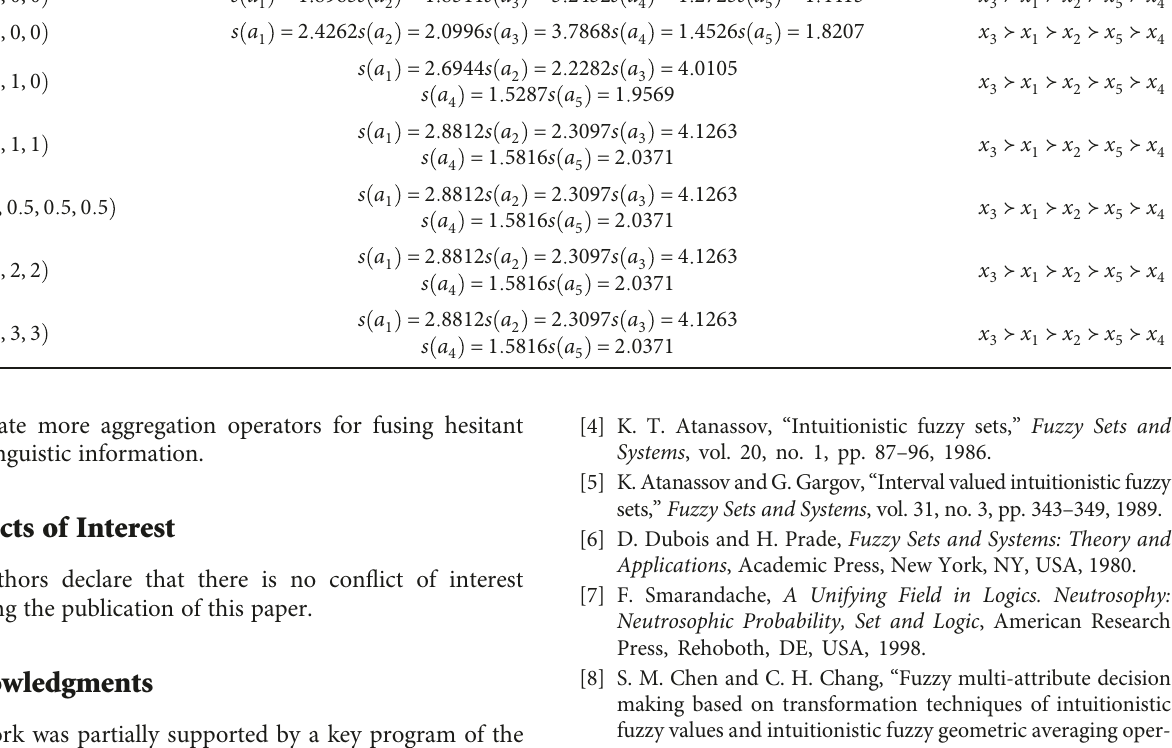
Table 6: Ranking results by assigning di ff erent values to parameter vector P in the HFLWDMM operator. Parameter P Scores of overall values Ranking results